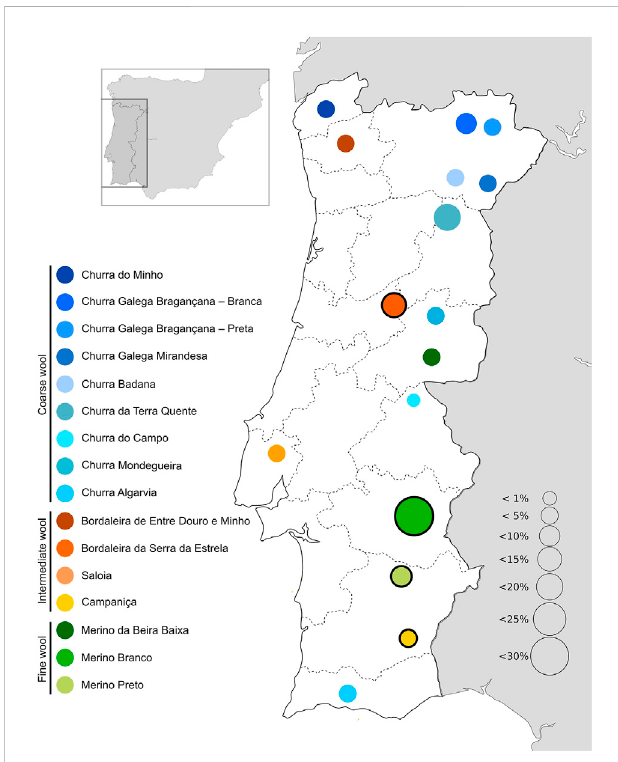
FIGURE 1 Geographical distribution and relative abundance of Portuguese native sheep breeds. The breeds sampled in this study are highlighted by a black